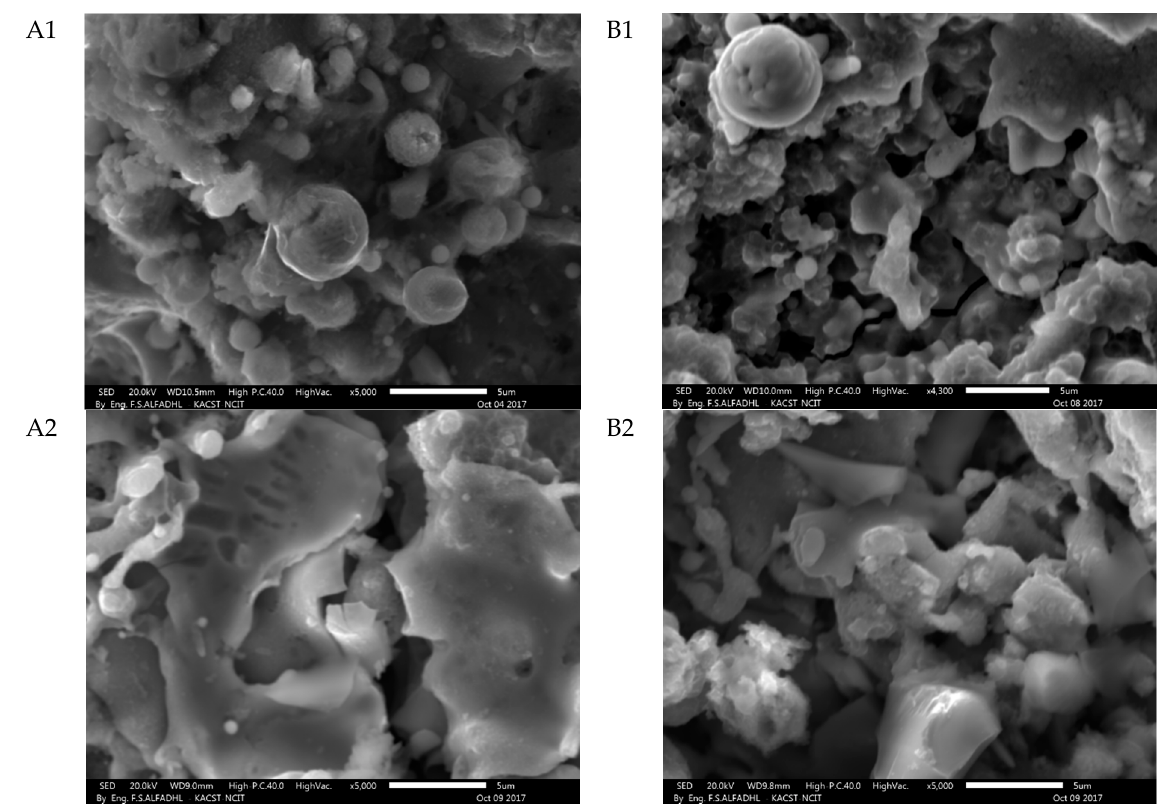
Figure 5. Secondary electron SEM images of the surface of the SiC-ZrB 2 for A1, B1, A2 and B2 coatings taken at 20 kV electron acceleration voltage at 500× (scale bar = 50 μ m) low magnifications.